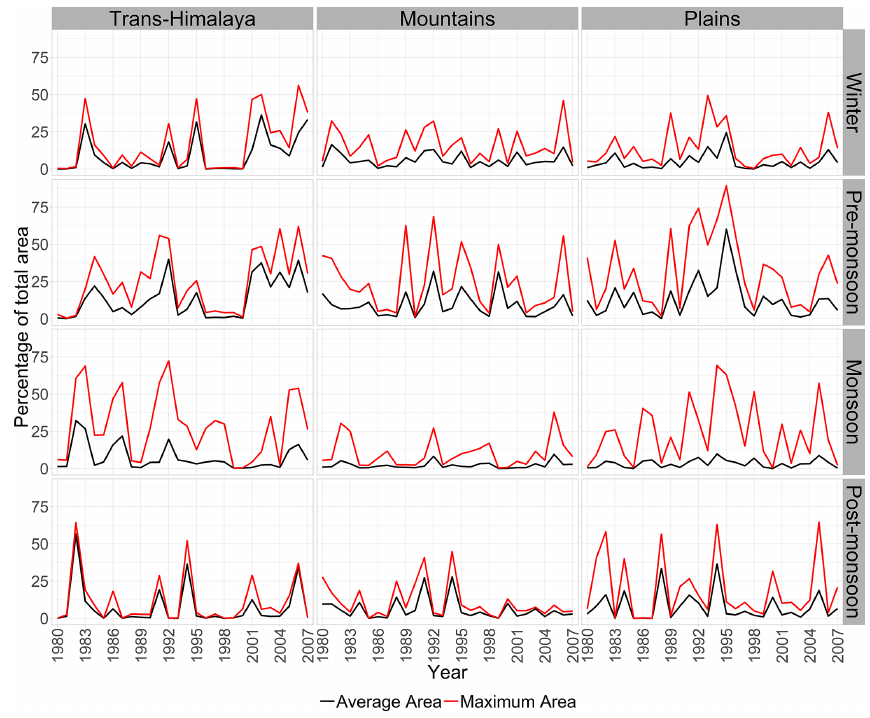
Figure 13. Area under drought (SMDI values below − 3) in the three regions of the KRB.